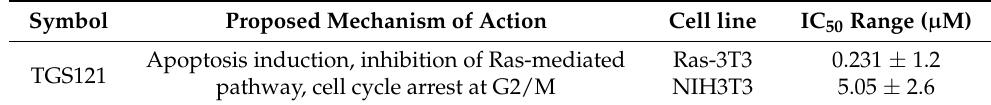
Table 5. Characterization of the anticancer properties of